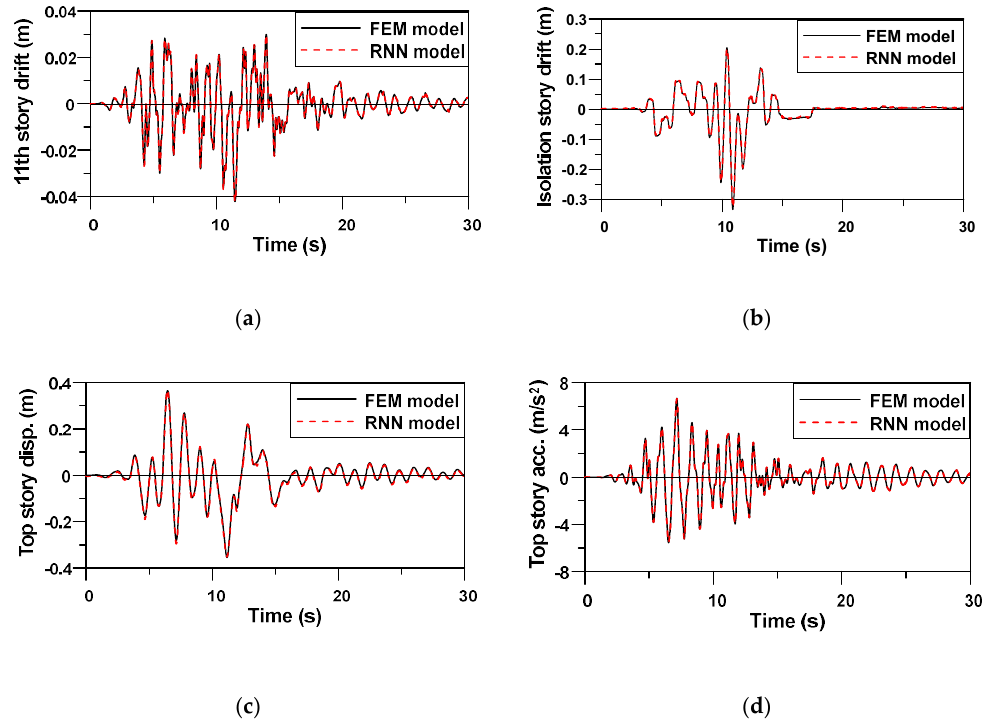
Figure 12. Comparison of the time history responses of Example 2 between FEM and RNN models (EQ No. 12): ( a ) 11 th story drift time history; ( b ) Isolation story drift time history; ( c ) Top story displacement time history; ( d ) Top story acceleration time history.